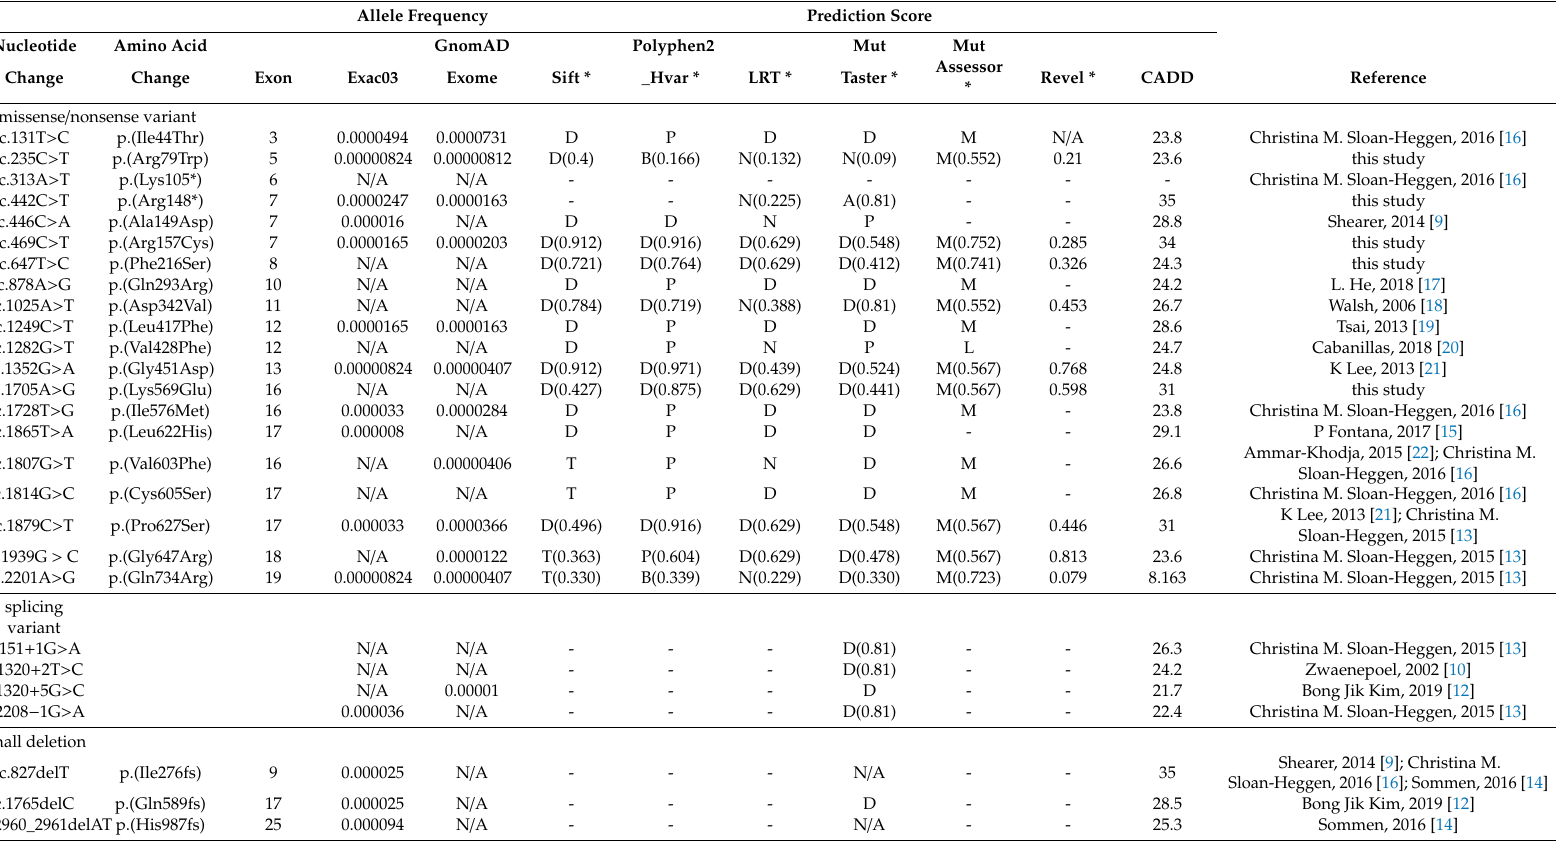
Table 3. Summary of variants identified in this and previous studies